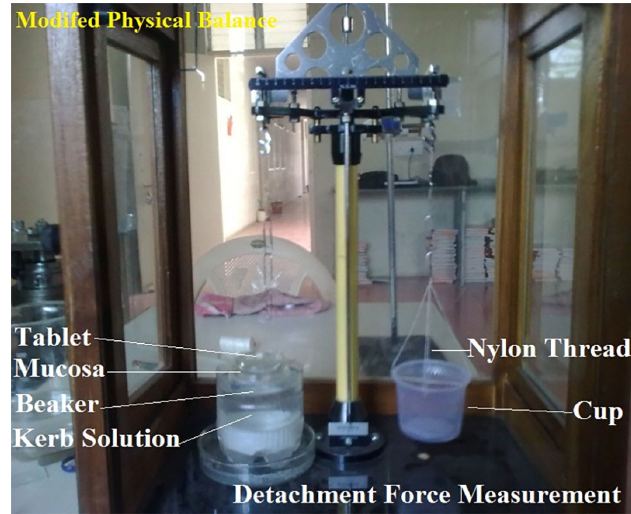
FIGURE 2 - Mucoadhesive strength measurement by detachment force measurement.